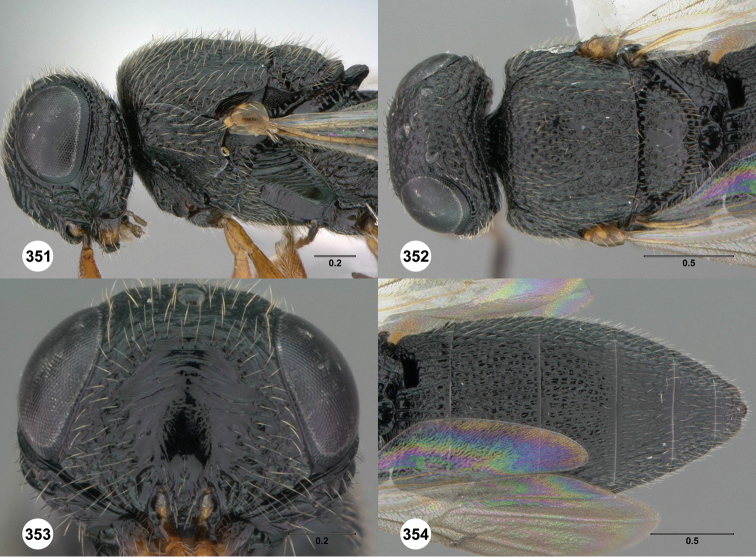
Oxyscelio stipulae sp. n., holotype female (OSUC 439590) 351 Head and mesosoma, lateral view 352 Head and mesosoma, dorsal view 353 Head, anterior view 354 Metasoma, dorsal view. Morphbank94